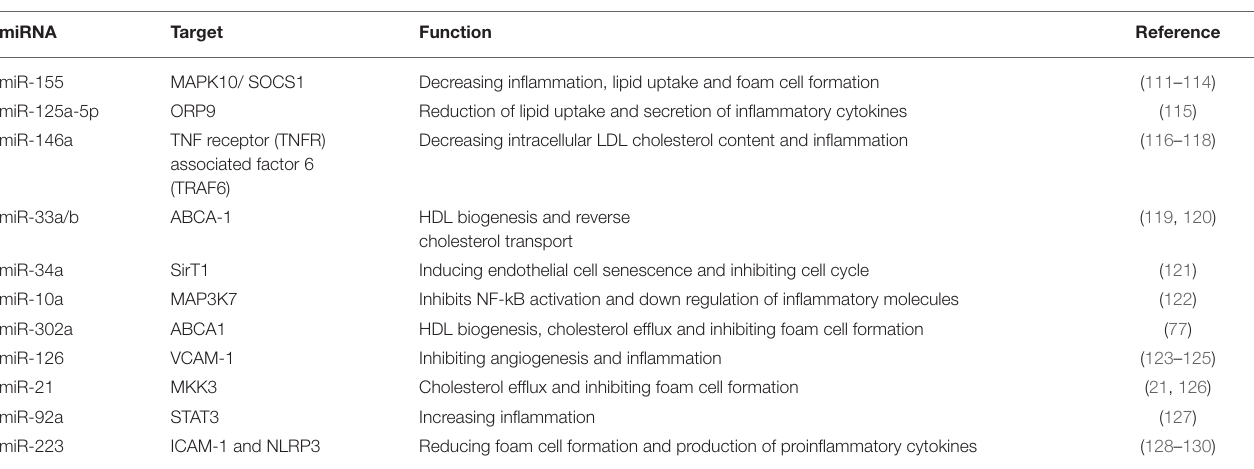
TABLE 2 | A list of microRNAs involved in lipid accumulation and